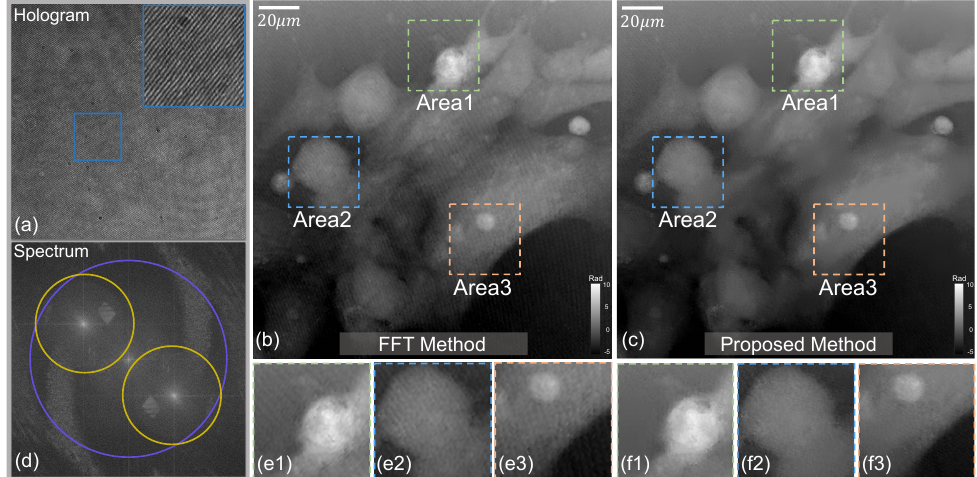
Figure 6. The experiment results of the COS-7 cells under the slightly off-axis DH system. ( a ) The captured hologram. ( b ) The reconstructed phase results based on the FT method. ( c ) The results recovered by our method. ( d ) The spectrum of ( a ), its SBU can reach 31.7% (the blue circle indicates 0-order and the yellow circles indicate ± 1-order.). ( e1 – e3 ) The detailed views of ROI in the phase results recovered by the FT method. ( f1 – f3 ) The detailed views of ROI in the phase results recovered by the proposed